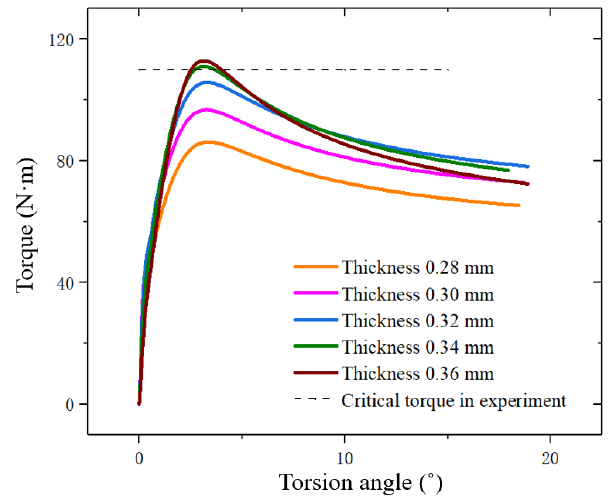
Figure 21. Angle-torque curves of toroid bellows with different wall thicknesses.